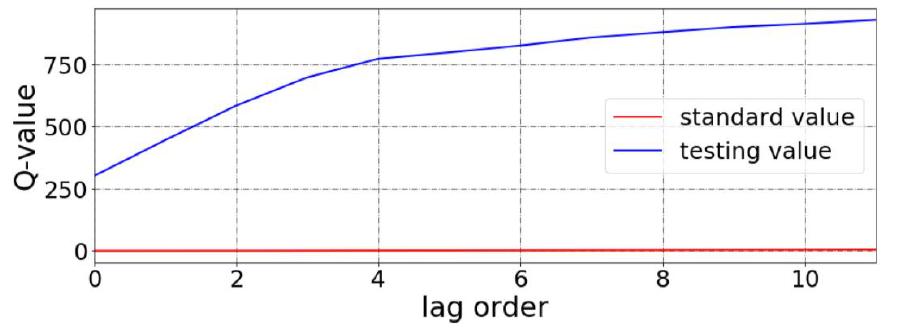
Figure 17. Box_Ljung value of each lag order. When the residual correction part was finished, the final point prediction result was generated. The process above is described in Figure 18.